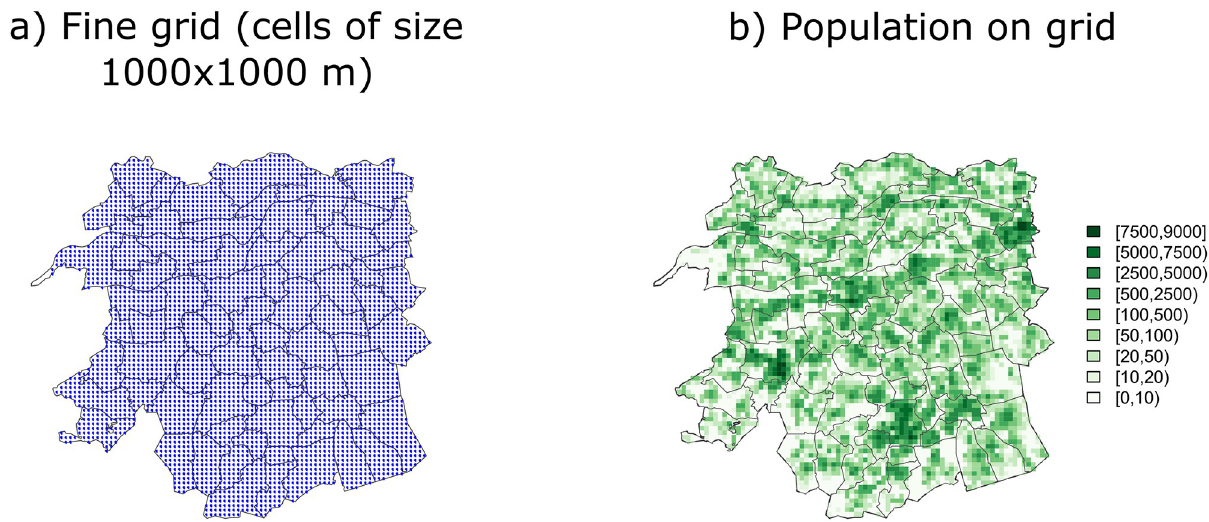
Fig 3. The map on the left shows the fine grid of 1000 × 1000 m cells in the study area shown in Fig 2b. The map on the right shows the spatial distribution of the population on this fine grid. Source: Estimated population density per grid-cell from the WorldPop project in 2009, the Netherlands https://www.worldpop.org/geodata/summary?id=42722. a) Fine grid (cells of size 1000x1000 m). b) Population on